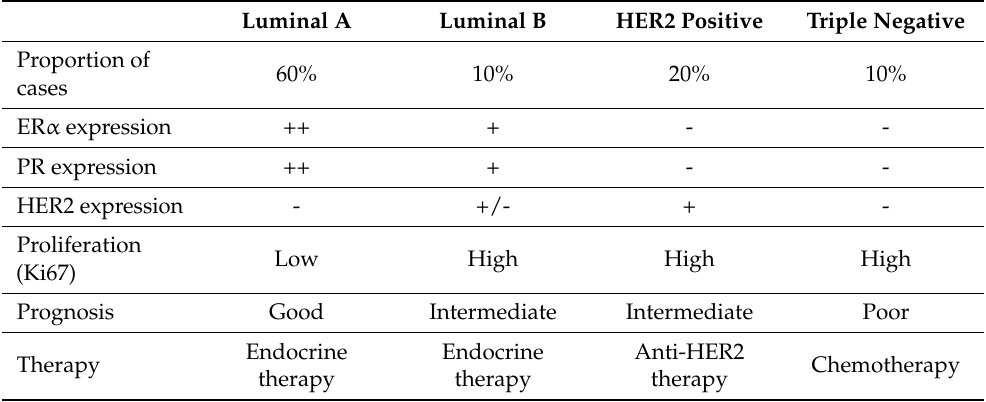
Table 1. Properties of the main breast cancer subtypes. Breast cancers can be classified according to the expression of certain receptors. These molecular profiles are correlated with the proliferation level of cancer cells and prognosis. In most cases, targeted therapies are available as adjuvants to surgery. ER α : estrogen receptor alpha; HER2: human epidermal growth factor receptor 2; PR: progesterone receptor. Luminal A Luminal